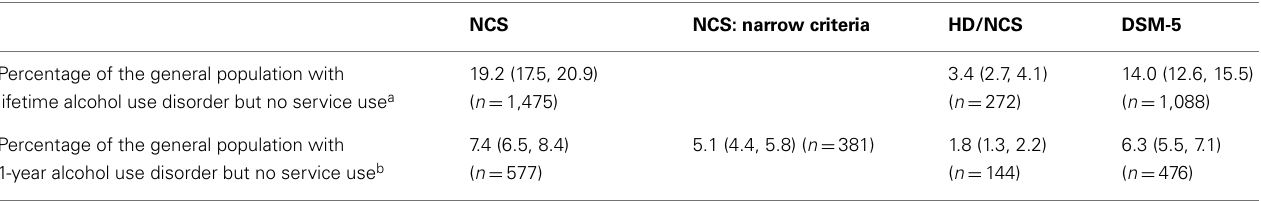
Table 6 | Unmet need: percentages (95% confidence intervals) of the general population having lifetime and 1-year alcohol use disorders but no use of services, using NCS, HD, and DSM-5 diagnostic criteria, ages 18–54, N = 7,599